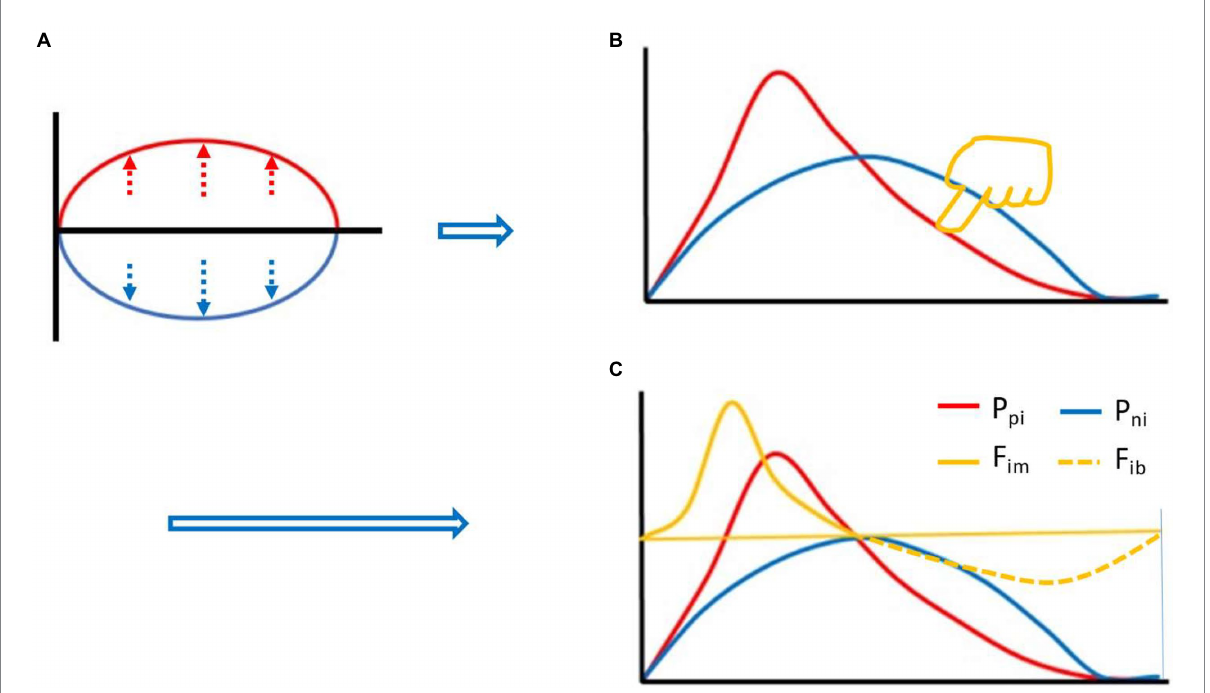
FIGURE 1 Thought experiment 1. It was assumed that during the whole process of immune response, the area under the curve (AUC) (red) of positive immune power (P pi ) was equal to the AUC (blue) of negative immune power (P ni ), namely AUC P pi = AUC P ni , or equation (2) described in the main text. Before the immune response, both were at baseline, where the red and blue lines overlapped with the horizontal axis. Suppose the red line went up and the blue line went down, an oval with the same area above and below the horizontal axis was created (A) . Flipping the blue line up and down and overlapping the red line, and stretching both curves to the same extent. Then, pressing the red line from the upper right toward the lower left with appropriate force (finger in yellow color, [B] ), an intersection point was created between the red line and the blue line (except for the starting and ending points) (B) . Before the intersection, the positive immune power was greater than the negative immune power, forming the immune force (F im ) and its dynamic curve ( [C] , yellow solid line), and obtaining its expression equation, namely, equation (3) described in the main text. After the intersection, the negative immune power was greater than the positive immune power, forming the immune braking force (F ib ) and its dynamic curve ( [C] , yellow dotted line), and obtaining its expression equation, namely, equation (4) described in the main